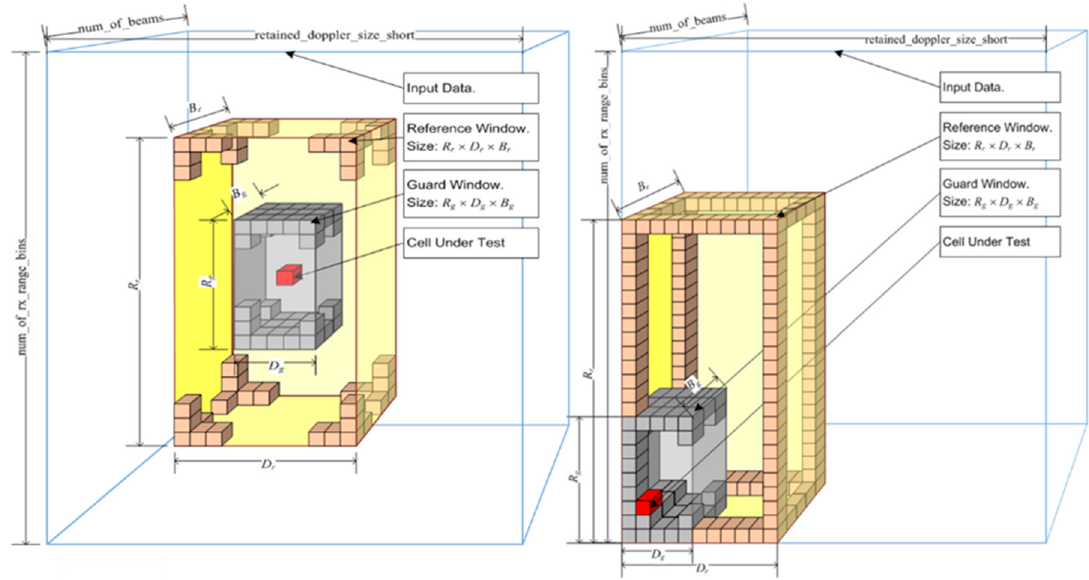
Figure 7. Construct of the CFAR engine.